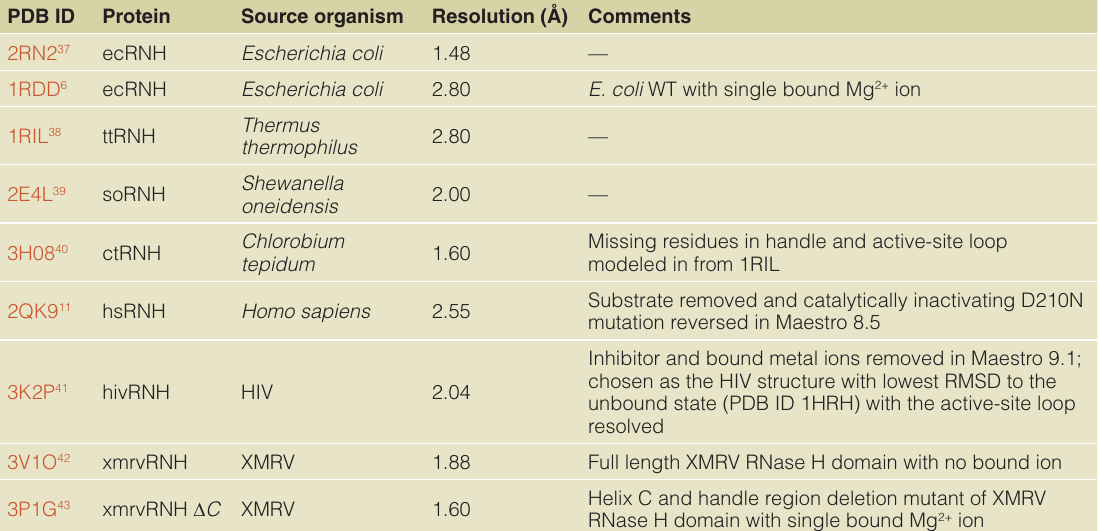
Table 1. Crystal structures used to initiate molecular dynamics simulations of RNases H. PDB ID